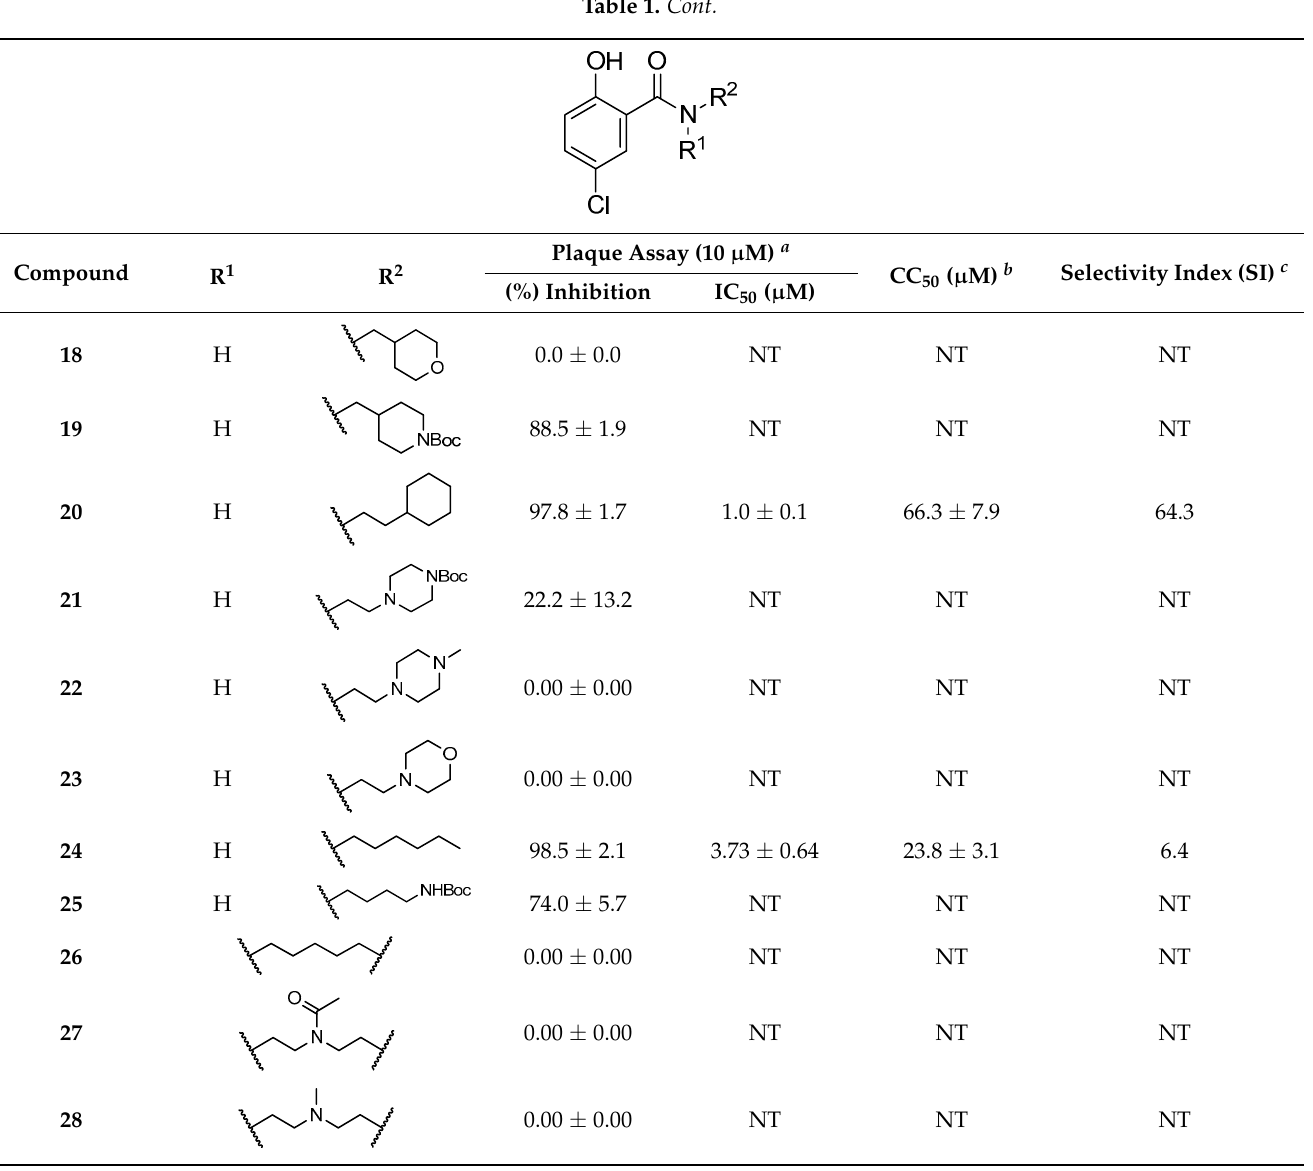
Table 1. Cont. Table 1. Inhibition of HAdV in plaque assay, cytotoxicity, and selectivity index for compounds 11–28.